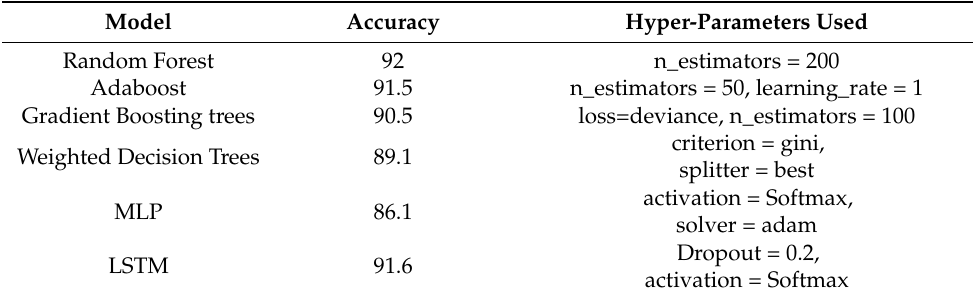
Table 4. Model Accuracy with different ML algorithms.